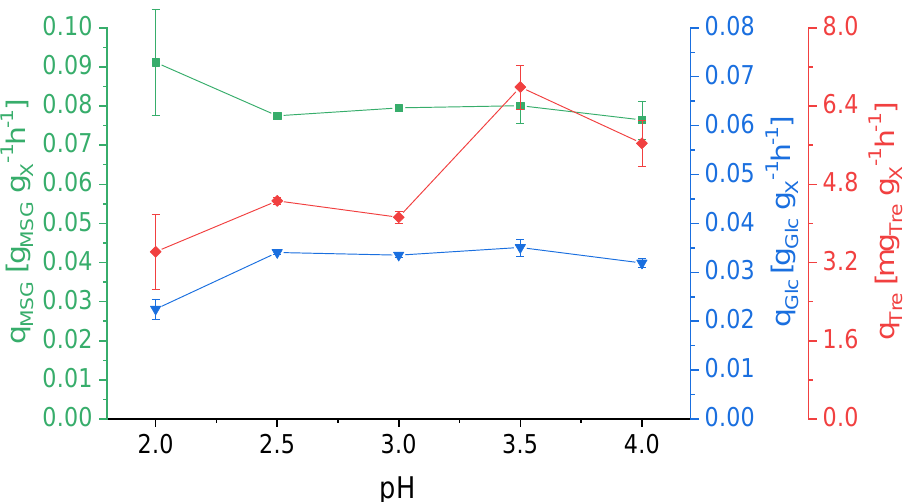
Figure 2. Specific uptake rates for L-glutamate (q MSG ) and D-glucose (q Glc ) and specific production rate of trehalose (q Tre ) in dependence of the pH value. Error bars indicate the difference between the various sampling points after reaching steady state in the continuous cultivation.